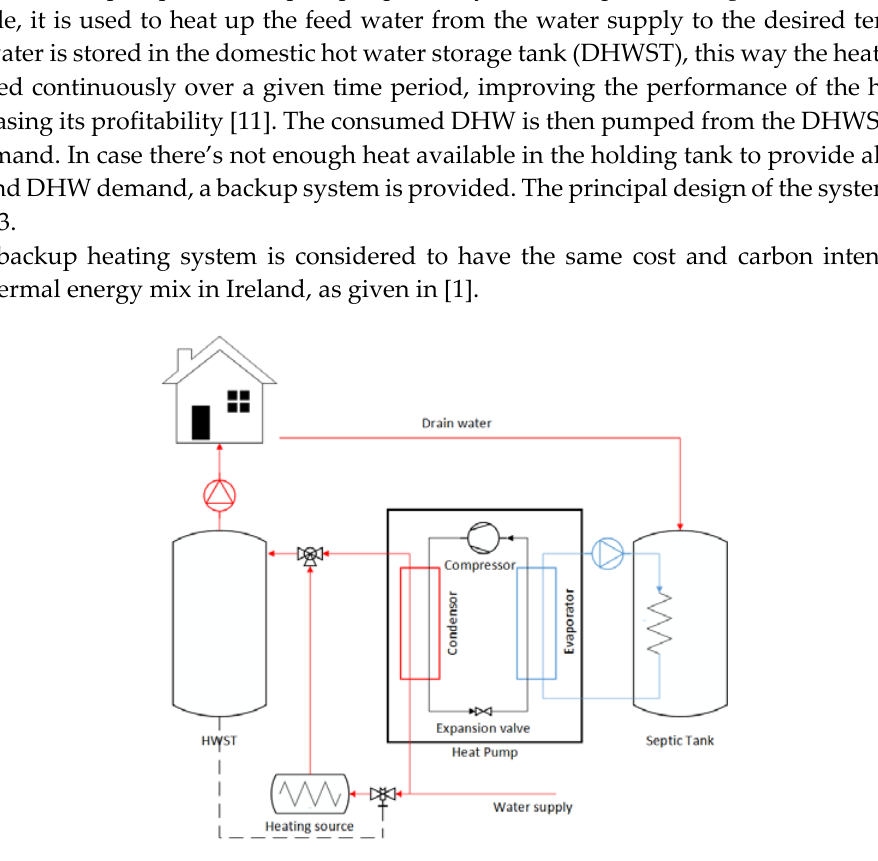
Figure 3. Principal design of the decentralized drain water heat recovery